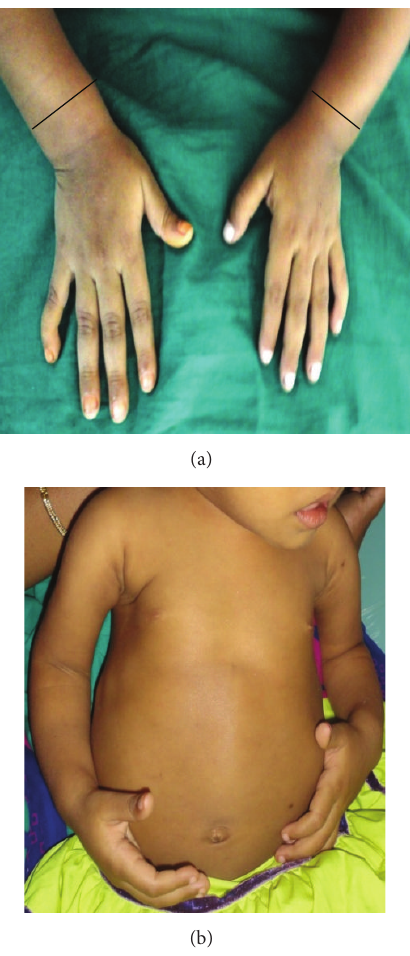
Figure 12: Showing widening of metaphysis.